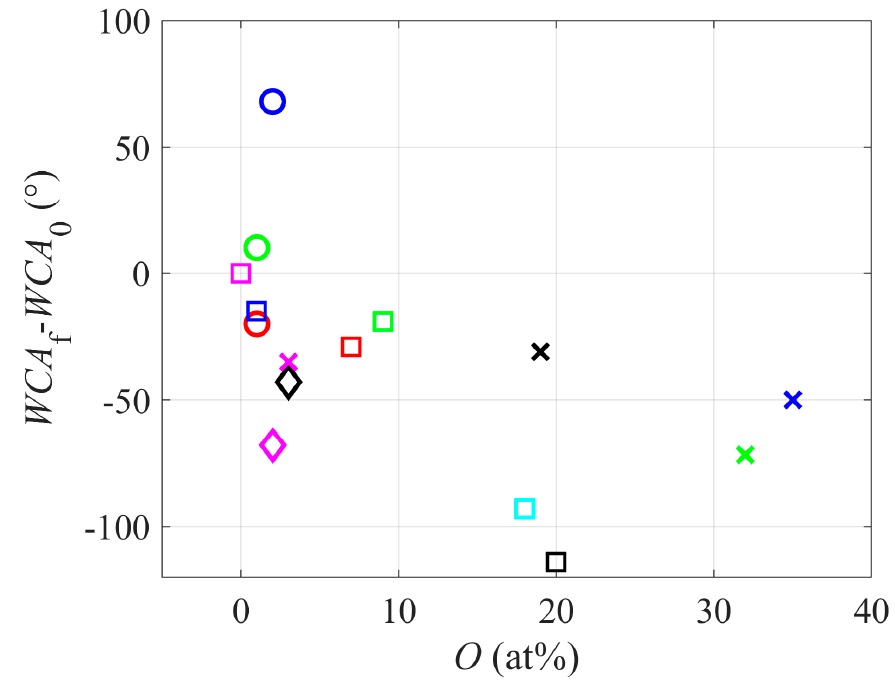
Figure 5. Change in the water contact angle versus oxygen concentration in the polymer surface film.